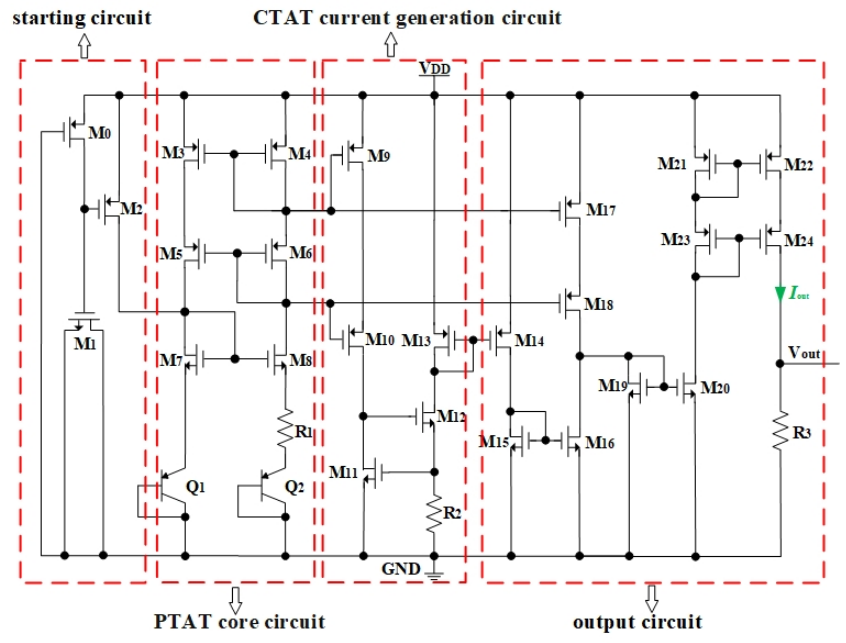
Figure 3. Schematic diagram of the optimized PTAT sensor.